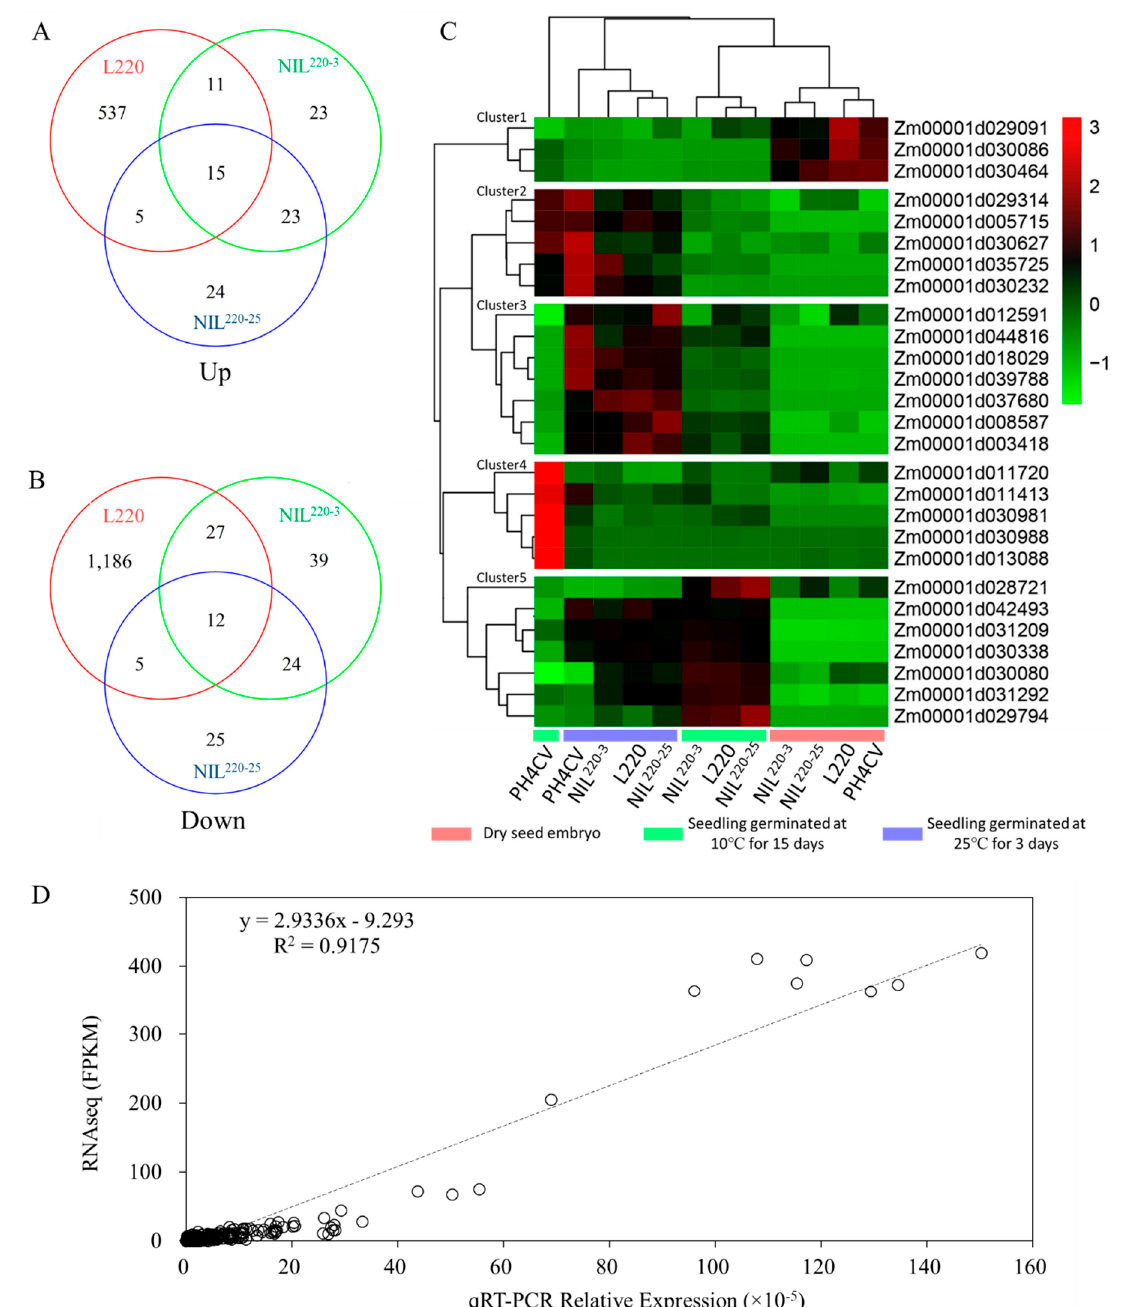
Figure 5. Common DEGs for tolerant line specially expressed LTGA genes. ( A , B ) Tolerant line (L220, NIL 220-3 , and NIL 220-25 ) specially expressed LTGA genes were identified from Figure 4, which were used for Venn diagram analysis to identify 15 commonly up- ( A ) and 12 downregulated ( B ) genes among the three tolerant genotypes. ( C ) Heat map for the 27 common DEGs. ( D ) qRT-PCR validation of the 27 common DEGs at low and normal germination